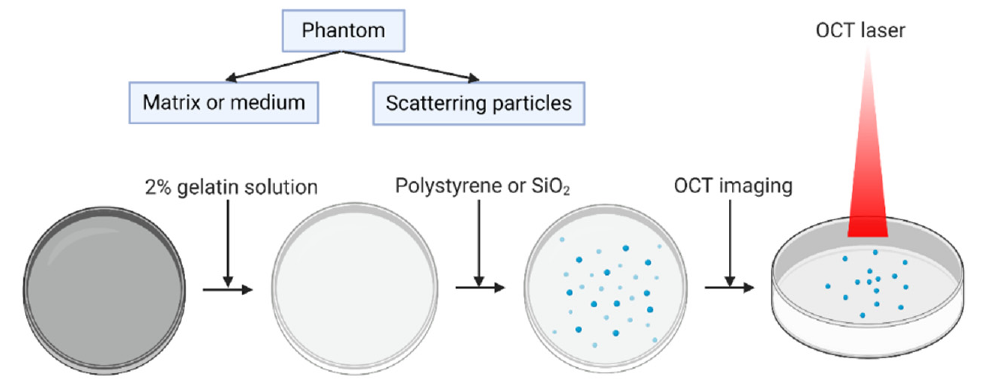
medium (gelatin = 1.33) and scatterer (polystyrene beads = 1.57) were determined using Figure 2.